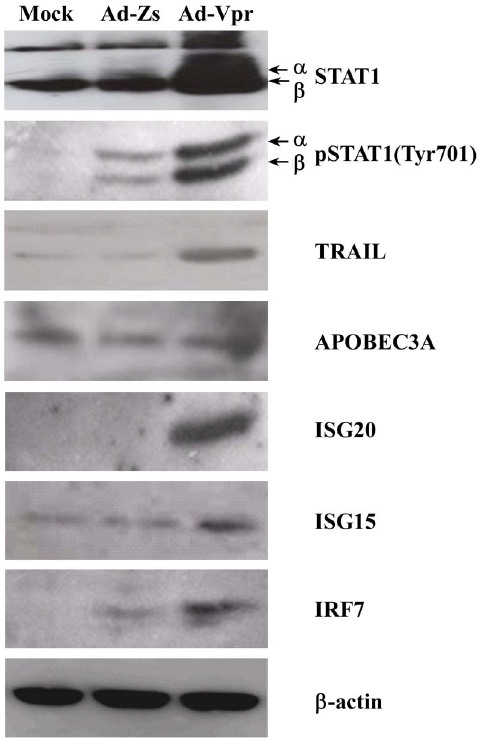
Figure 7. Validation of differentially expressed genes at the protein level. Human monocyte-derived macrophages (MDMs) were infected with Ad-Vpr or Ad-Zs, or mock-infected as a control. At 48 h post-infection, the cells were washed, lysed, and subjected to Western blot analyses with the indicated antibodies. A b -actin antibody was used as a loading